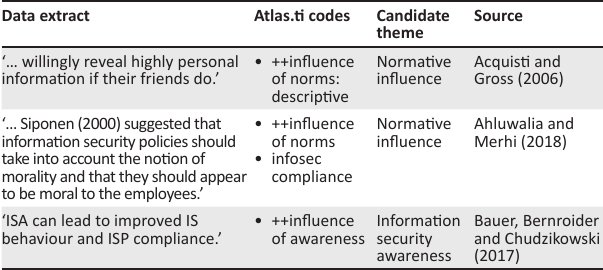
Full-text ar(cid:21)cles excluded due to relevance